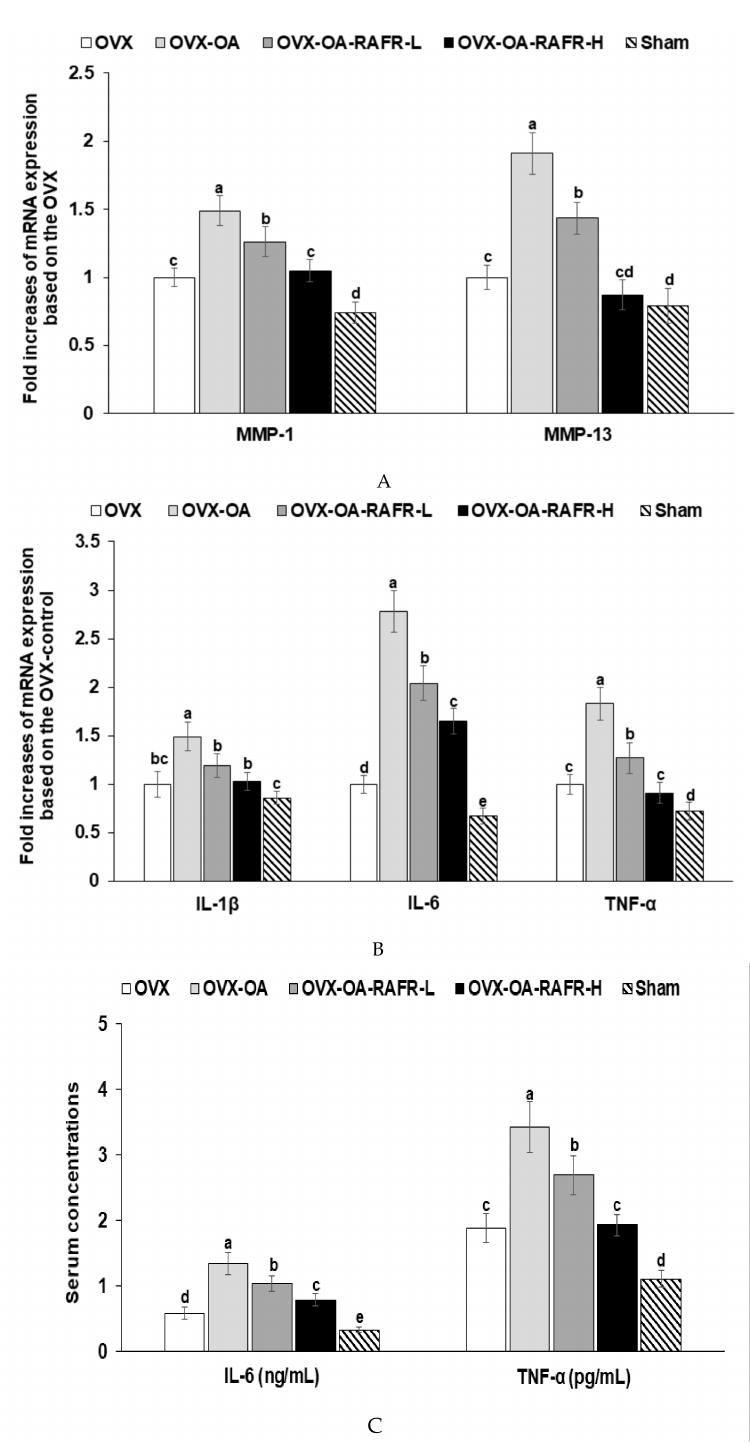
Figure 5. The mRNA expression of matrix metalloproteinases and pro-inflammatory cytokines in the articular cartilage after 21 days of intra-articular injection of monoiodoacetate (MIA) Ovariectomized (OVX) rats were divided into four groups: (1) MIA injection into the knee joint and fed a high-fat diet containing 0.23% rice + 0.018% AFR diet (RAFR-L). (2) MIA injection into the knee joint and fed a high-fat diet containing 0.69% rice + 0.053% AFR diet (RAFR-H), (3) MIA injection into the knee joint and fed a high-fat diet containing 0.053% cellulose (OA-control). (4) saline injection into the knee joint and fed a high-fat diet containing 0.053% cellulose (non-OA control). Sham rats had the same diet